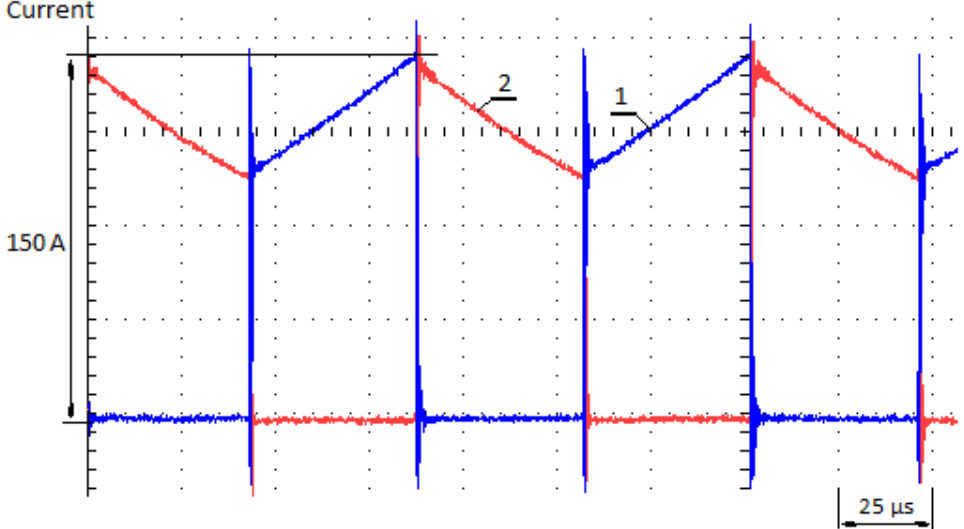
Figure 14. Buck mode of operation. Current through the inductor during 1–switched-on and 2– switched-off of transistor Q1.